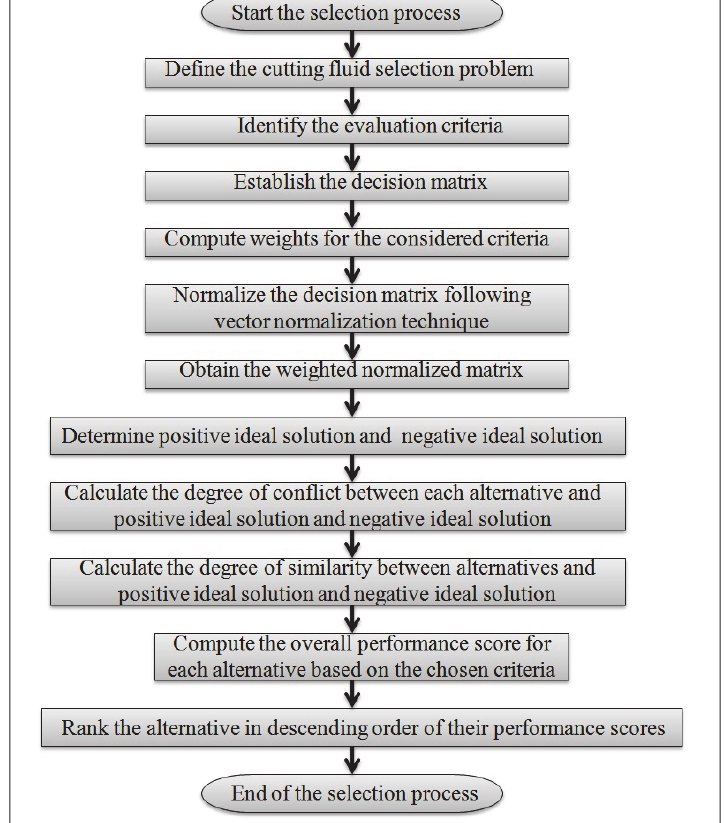
Fig. 3. Flowchart for the modified similarity-based